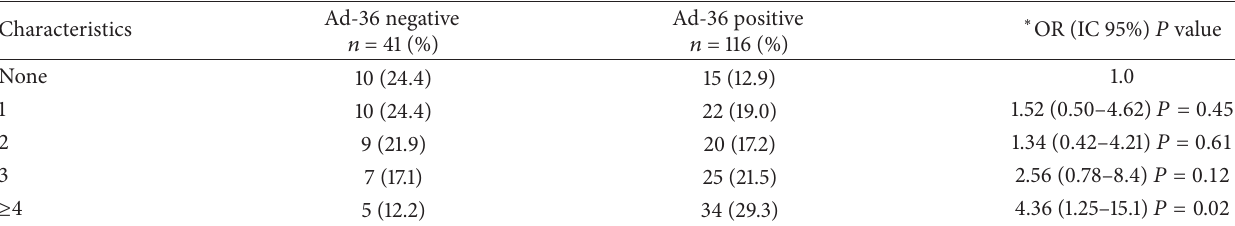
Table 4: Ad-36 seropositivity and number of metabolic